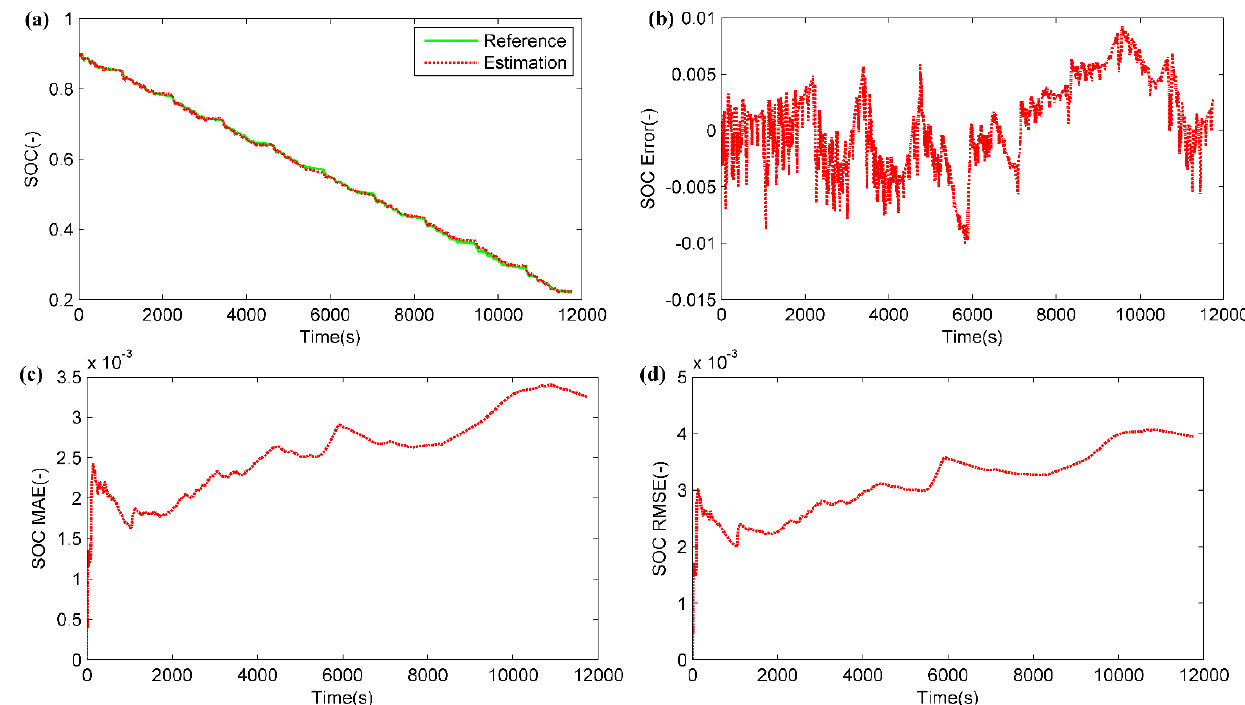
Figure 9. SOC estimation results with accurate initial SOC for LCO battery cell: ( a ) Comparative profiles of reference and estimated SOC; ( b ) Error of SOC estimation; ( c ) MAE of SOC estimation; ( d ) RMAE of SOC estimation.